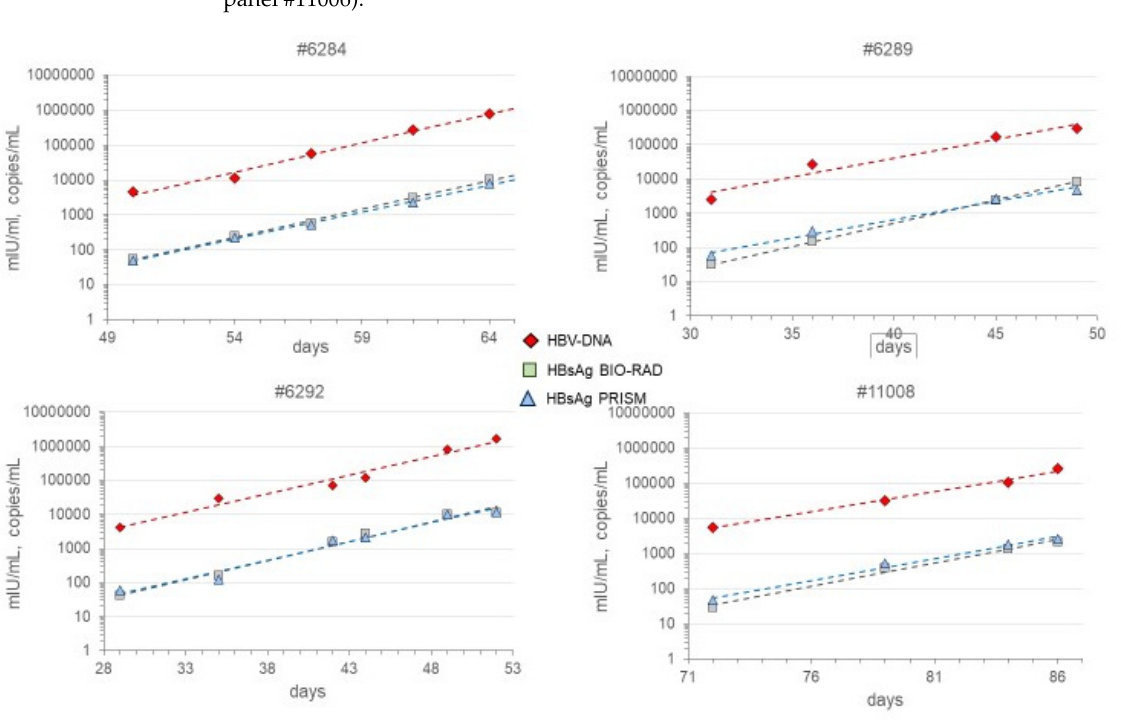
Figure 3. Parallel increase of Log HBV-DNA (bDNA 3.0 assay) and Log HBsAg concentration (PRISM and BIO-RAD assays) during ramp-up phase of viremia in seroconverting plasma donors (seroconversion panels #6284, #6289, #6292, and #11008). For each of the seroconversion panels the time point where the HBsAg signal crosses the cutoff was calculated from the regression line between Log IU/mL HBsAg and time (Figure 2). The corresponding HBV-DNA concentration at the HBsAg cutoff crossing points was calculated from the HBV-DNA regression line (Figure 2). The geometric mean (and range) of the HBV-DNA concentrations at the HBsAg seroconversion points were